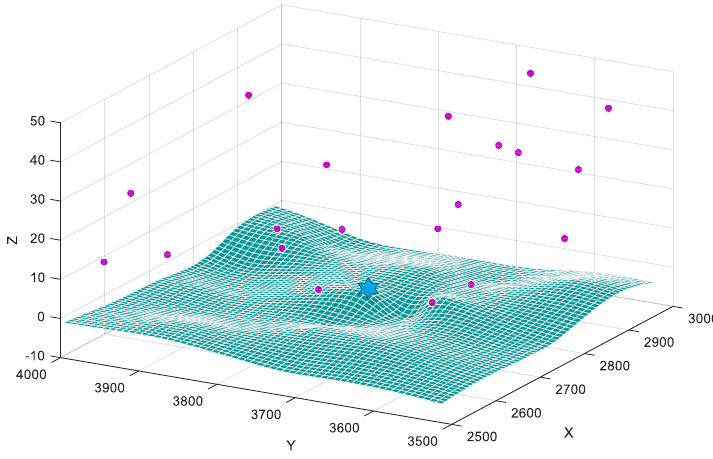
Figure 6. Simulation scenario.